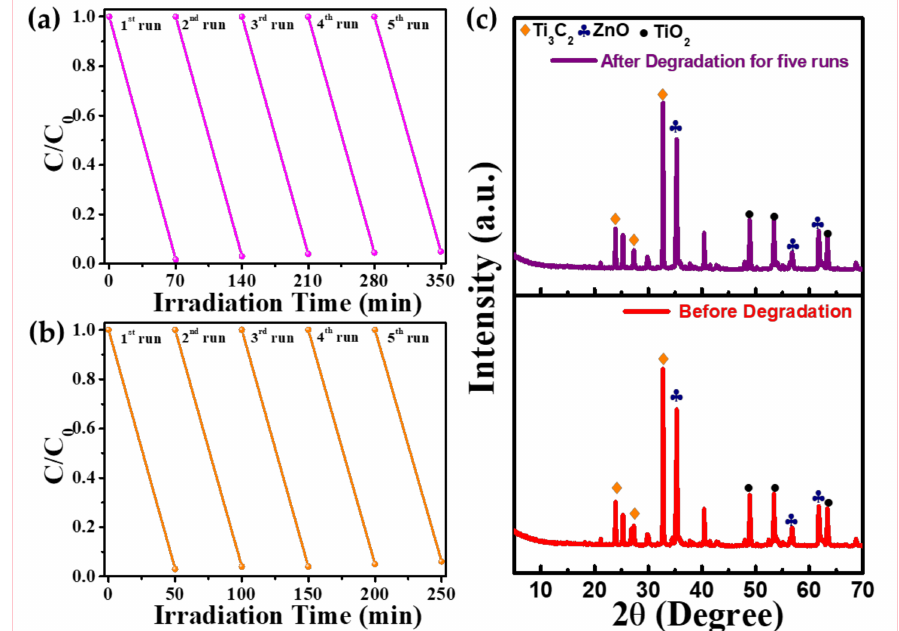
Figure 7. Recyclability of the ZnO / Ti 3 C 2 T x -2 photocatalyst for photocatalytic degradation of ( a ) RhB and ( b ) MO. ( c ) XRD patterns of the hybrid photocatalyst before and after the cyclic photodegradation tests of